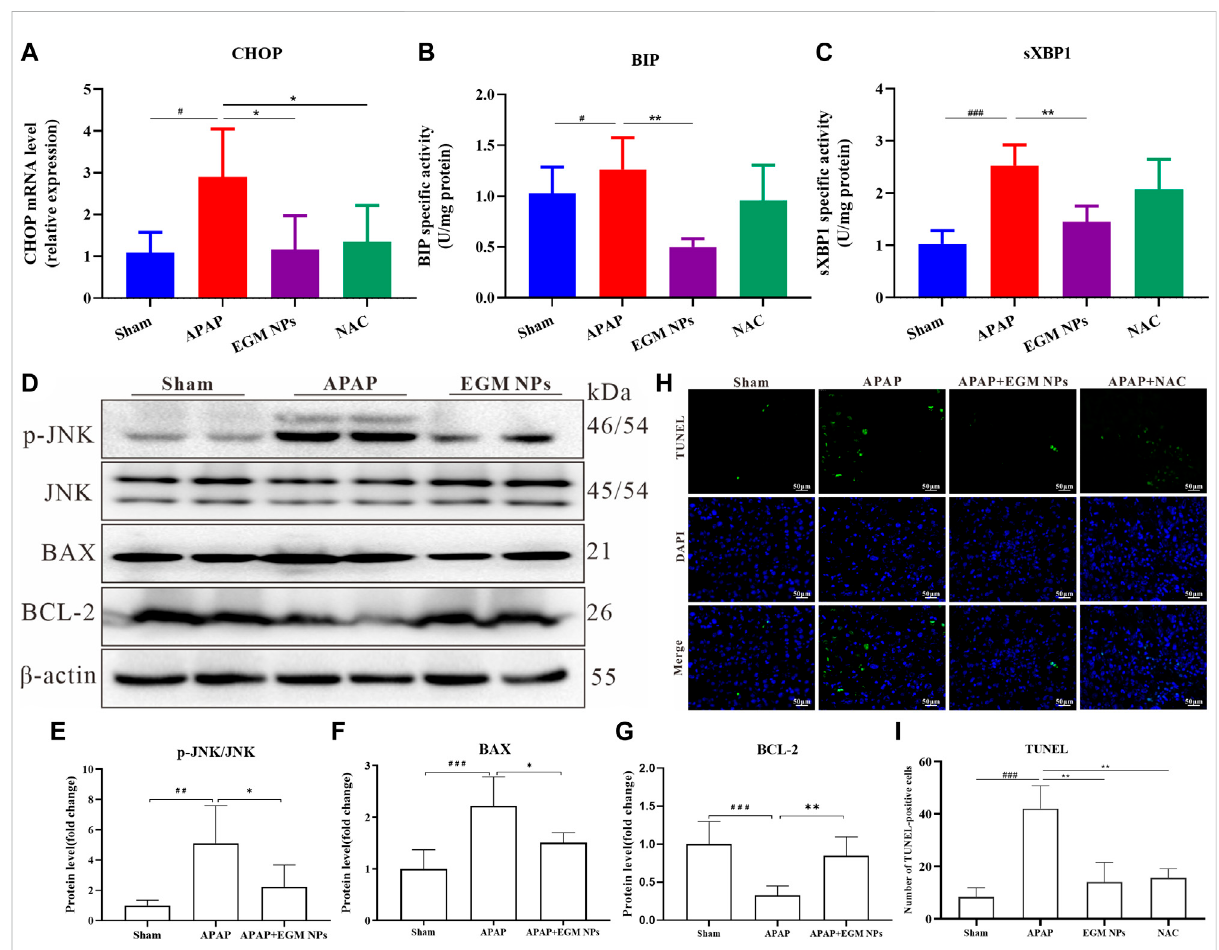
FIGURE 5 EGM NPs alleviate ER stress and cell apoptosis. (A – C) mRNA levels of CHOP (A) , BIP (B) and sXBP1 (C) in liver tissue homogenates from each group. (D) Westernblotanalysisofp-JNK,JNK,BAXandBCL-2proteinsexpressioninlivertissuehomogenatesfromeachgroup. (E,F) Quanti fi cation of the protein immunoblots of p-JNK/JNK (E) , BAX (F) and BCL-2 (G) . TUNEL staining (green fl uorescence), DAPI (blue fl uorescence) staining, and their mergeimagesofliver tissuesfrom eachgroup. Scale bar:50 μ m. (I) Quanti fi cationof TUNEL-positivecellsin (H) . (* p < 0.05, ** p < 0.01, vs